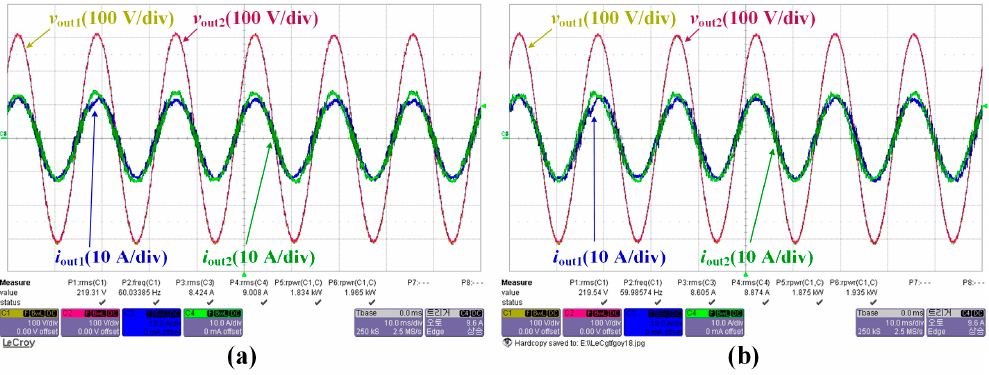
Figure 14. Experimental waveforms of using ( a ) conventional droop control and ( b ) the proposed control strategy with resistive load (12.4 Ω ).